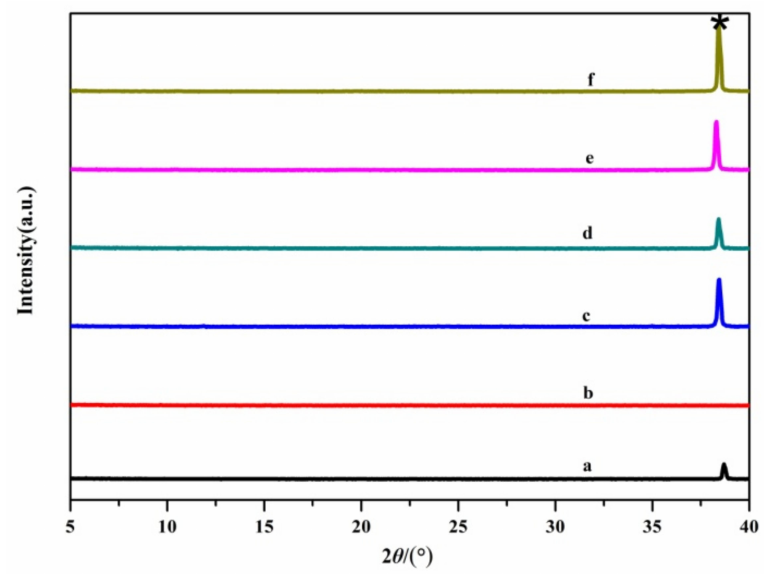
Figure 14. XRD patterns of the 1060, 2024 and 7075 aluminum alloys ( a , c , e ) and their anodic oxide films ( b , d , f ). * represents the aluminum peak.